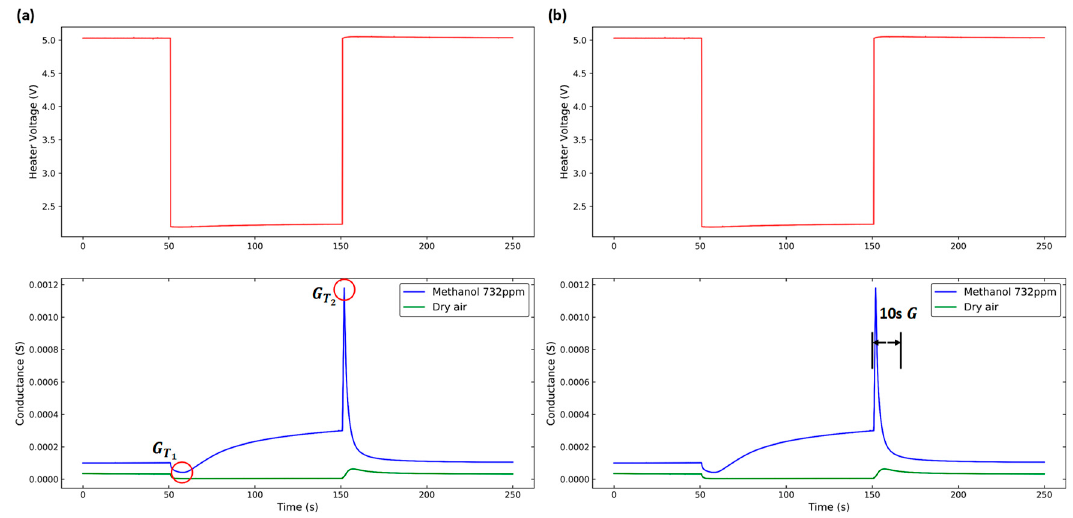
Figure 4. Feature extraction methods: ( a ) Peak response and ( b ) dynamic response.